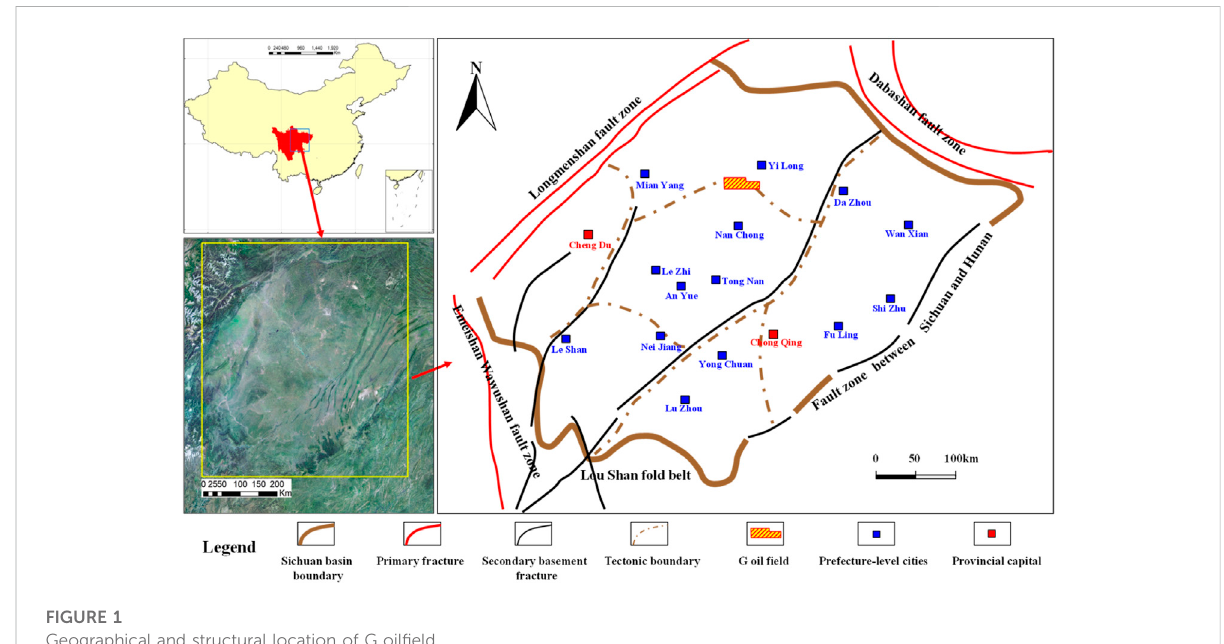
FIGURE 1 Geographical and structural location of G oil fi eld.